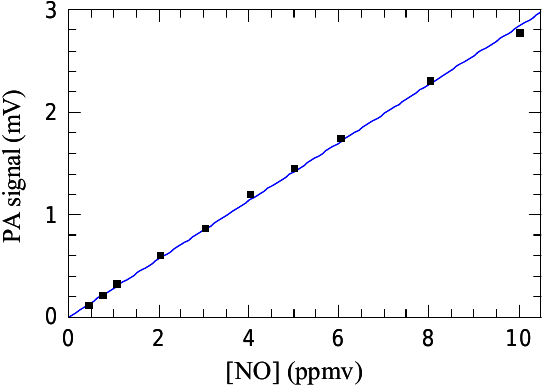
Figure 3. Photoacoustic signal from QCL-based PA cell versus NO concentration.